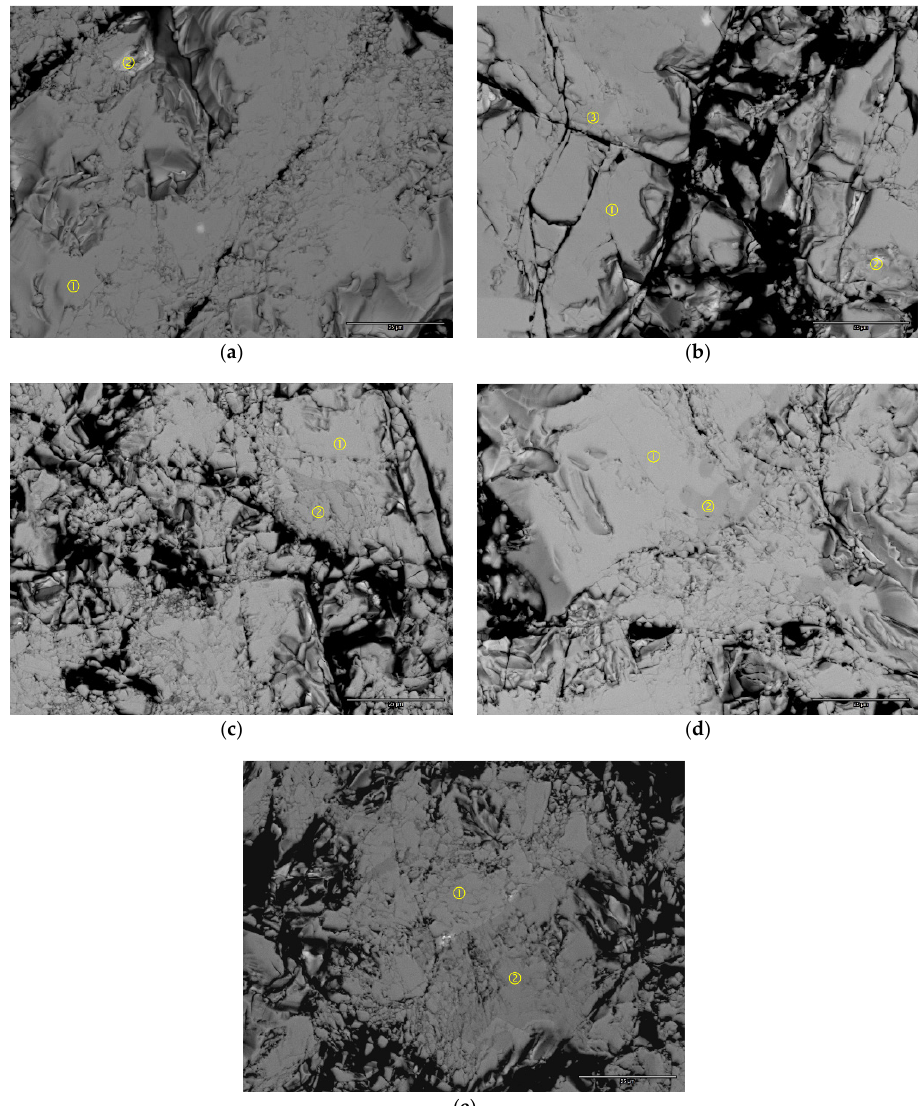
Figure 5. Scanning electron microscope-backscattered electron (SEM-BSE) micrographs from alloys ( a ) Fe1; ( b ) Fe2; ( c ) Fe3; ( d ) Fe4; and ( e ) Fe5. The bar on the lower right corner represents 25 microns.